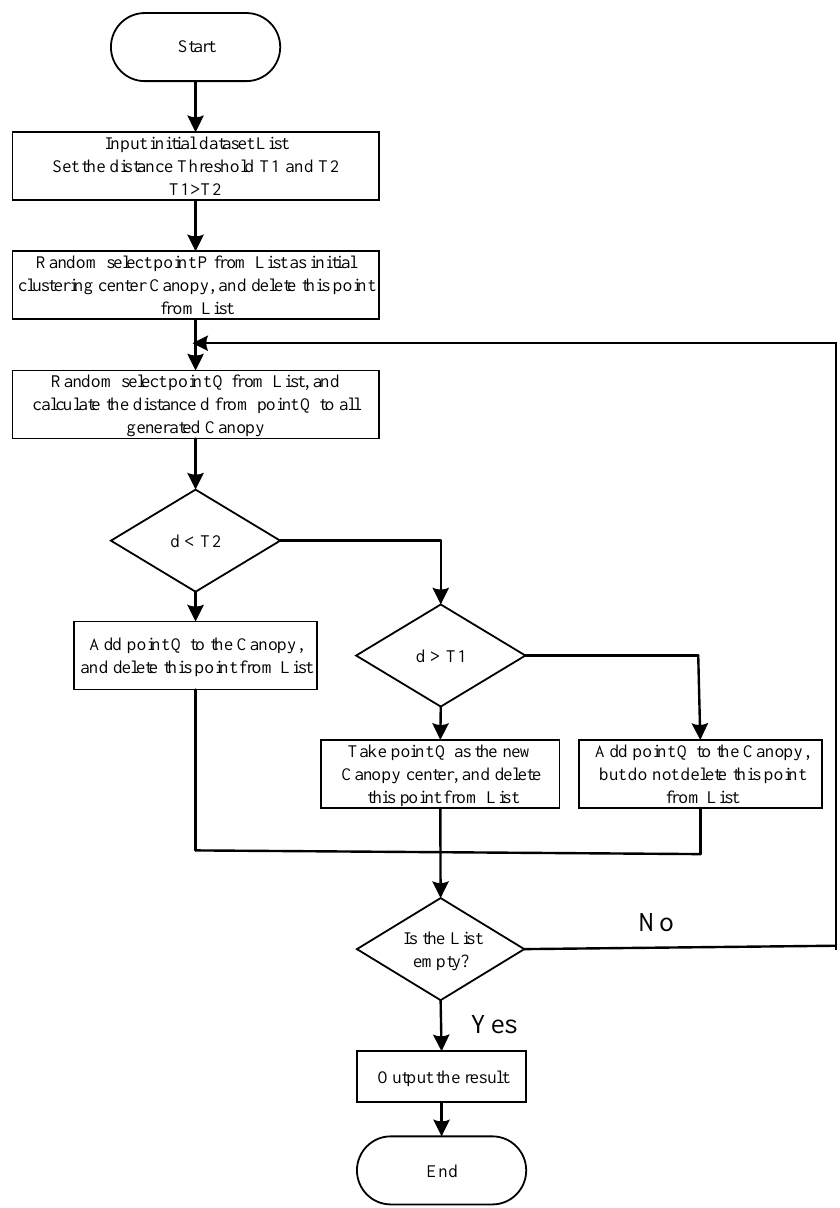
Figure 2. Flowchart of the Canopy algorithm.